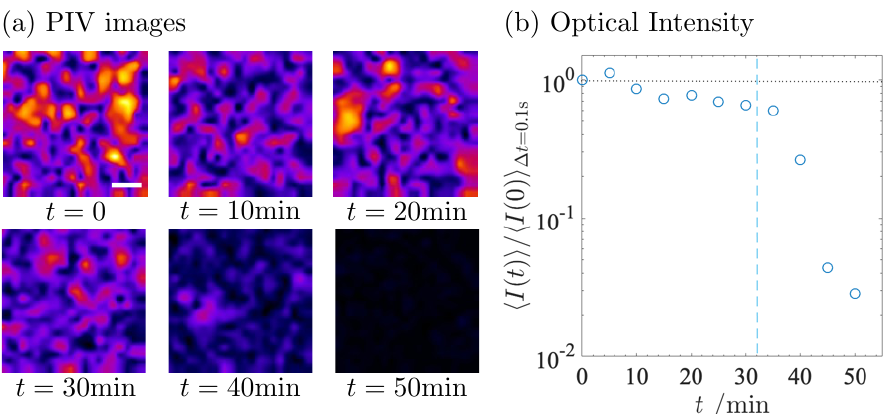
Figure 2. ( a ) PIV images obtained at fixed time lag ∆ t = 0.1 s at various times t . Scale bar corresponds to 10 µ m. ( b ) Normalized optical intensity < I ( t ) > / < I ( 0 ) > ∆ t = 0.1 s calculated from PIV image at time lag ∆ t = 0.1 s as a function of t . Vertical dashed line indicates t = 32